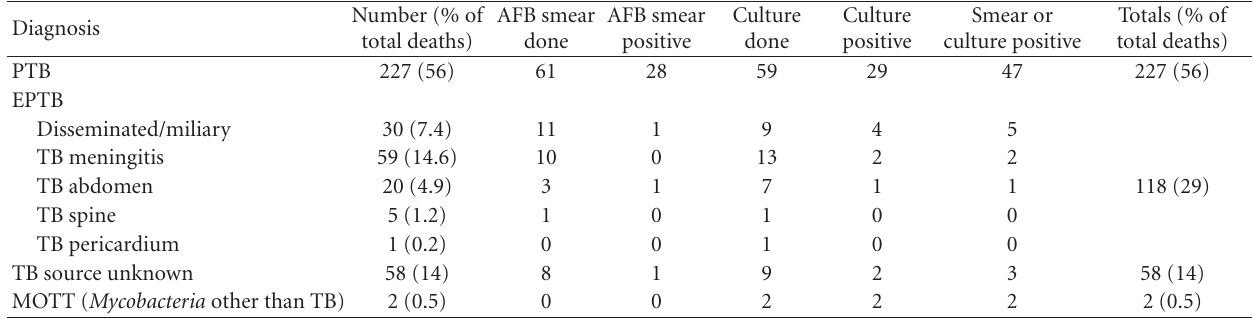
Table 2: Number of TB-attributed inpatient deaths, by disease site and diagnostic test.